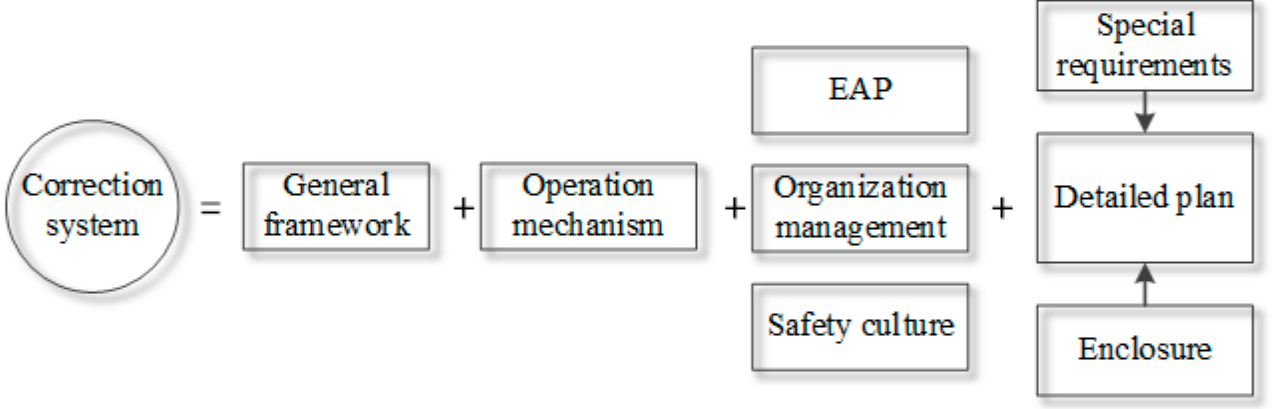
Figure 10. The structure diagram of correction system about “1 + 1 + 3 +